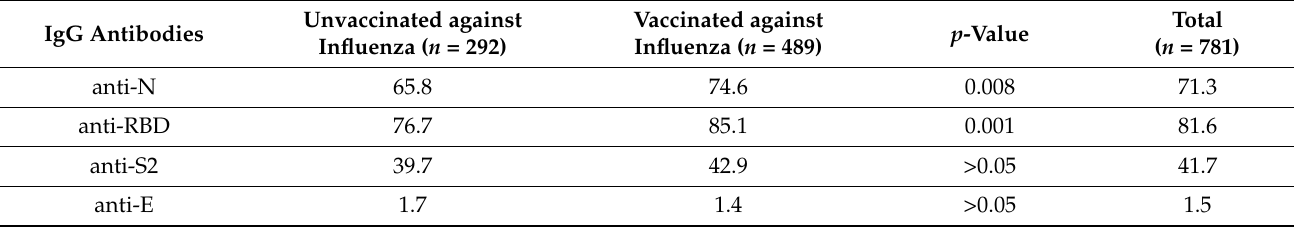
Table 2. The frequencies (%) of IgG antibodies against SARS-CoV-2 nucleocapsid protein (anti-N), receptor binding domain of spike protein (anti-RBD), subunit S2 of spike protein (anti-S2), and envelope protein (anti-E) in mild COVID-19 convalescent individuals not vaccinated and vaccinated against seasonal influenza. The p -value refers to difference between these groups examined with Pearson’s χ 2